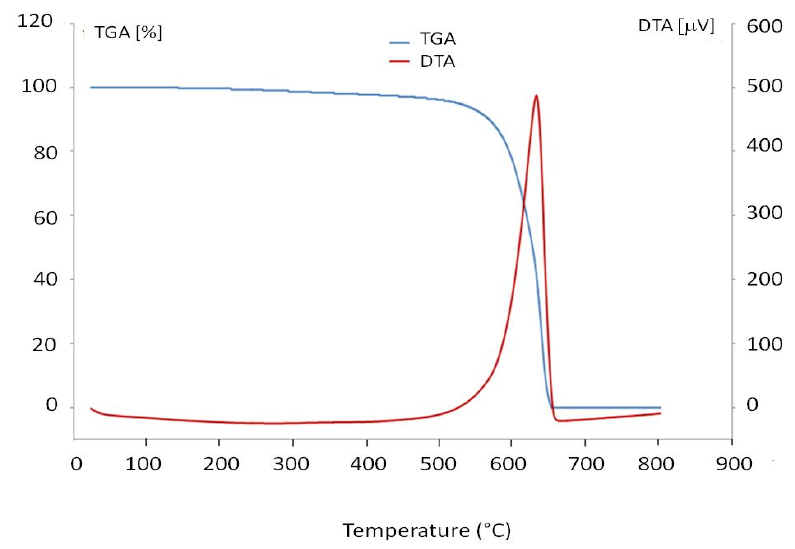
Figure 1. TGA and DTA curves of the purified multiwalled carbon nanotubes (MWCNTs).